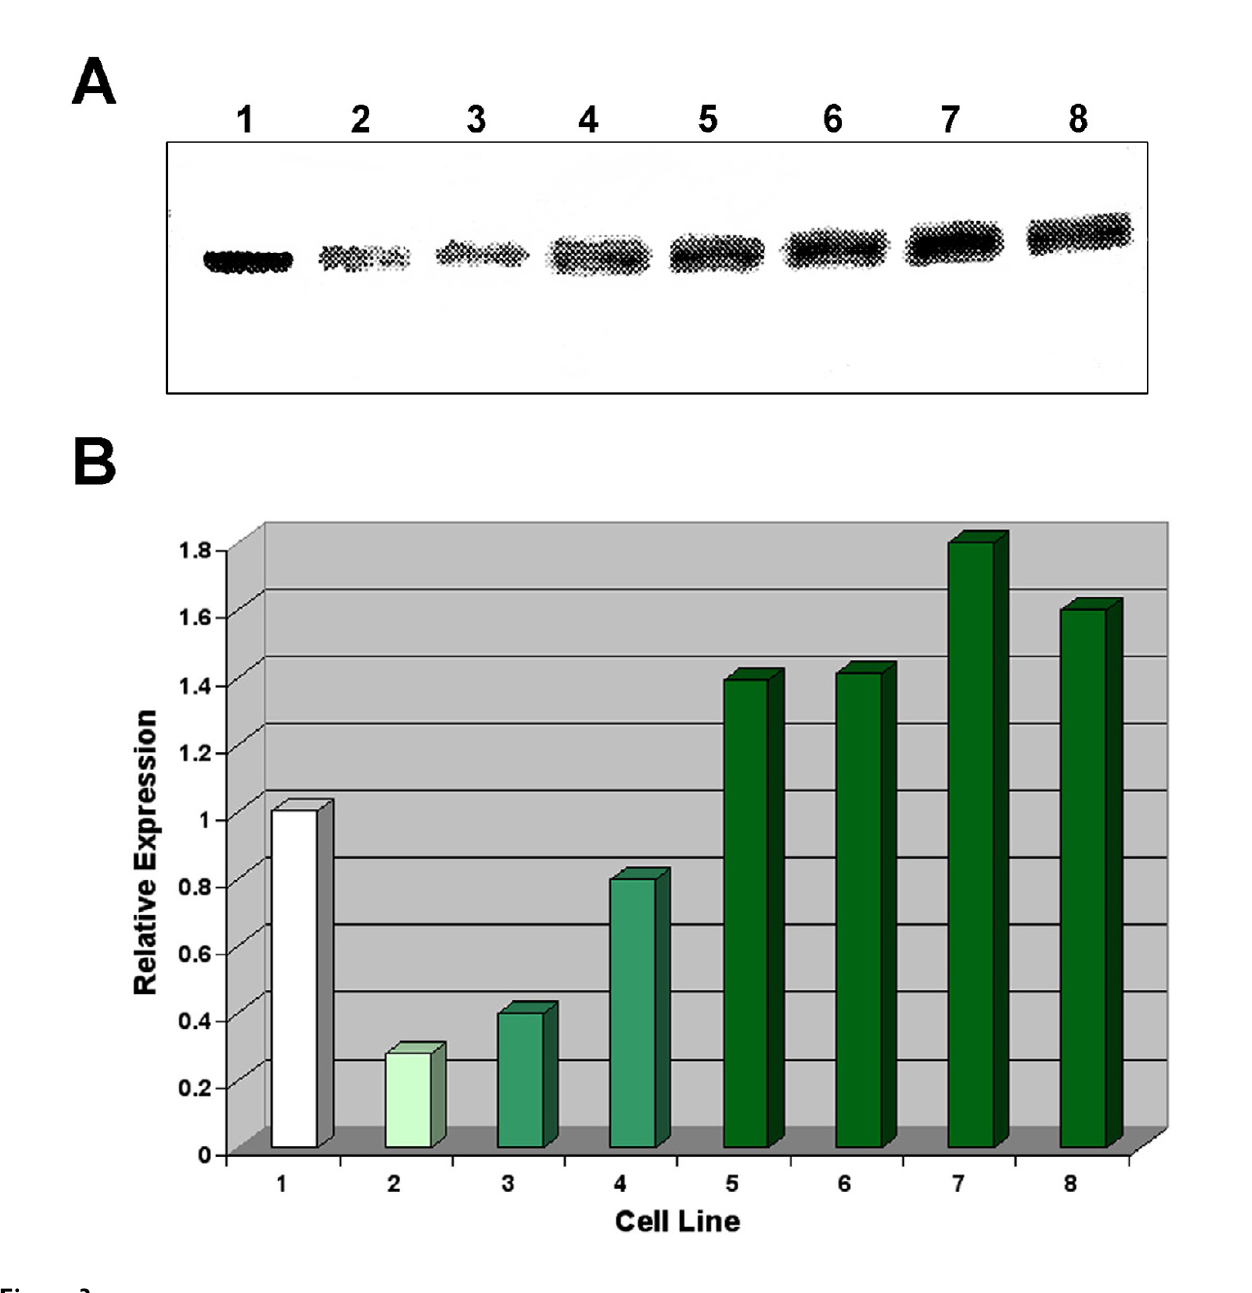
Figure 3 The expression of GFP-BLM is inducible in stable transfected BS cells. A. Equal amounts of total protein (10 µ g) from whole cell lysates were resolved on a SDS-polyacrylamide gel and transferred to a membrane. The bound primary α -BLM and goat α -rabbit alkaline phosphatase conjugated secondary antibody complexes were quantitated using a ECF fluorescent alkaline phosphatase substrate. 1) GM0637G normal SV40-transformed fibroblast cells (0.17), 2) HG2522-1a cells + GFP-BLM gene no inducer (0.03), 3) +0.0625 µ g/ml Tet (0.05), 4) +0.125 µ g/ml Tet (0.11), 5) +0.25 µ g/ml Tet (0.16), 6) +0.5 µ g/ml Tet (0.3), 7) +1 µ g/ml Tet (0.3), 8) +2 µ g/ml Tet (0.14). The ECF fluorescent product was visualized directly with a Molecular Dynamics Storm PhosphorImager. B. The fluorescent image was quantitated using Imagequant. The amount of BLM in the lysates was normalized to the amount in equivalent total protein in the GM0637G cells. The data points are the average of two experiments. The standard deviations for each concentration are reported in parentheses